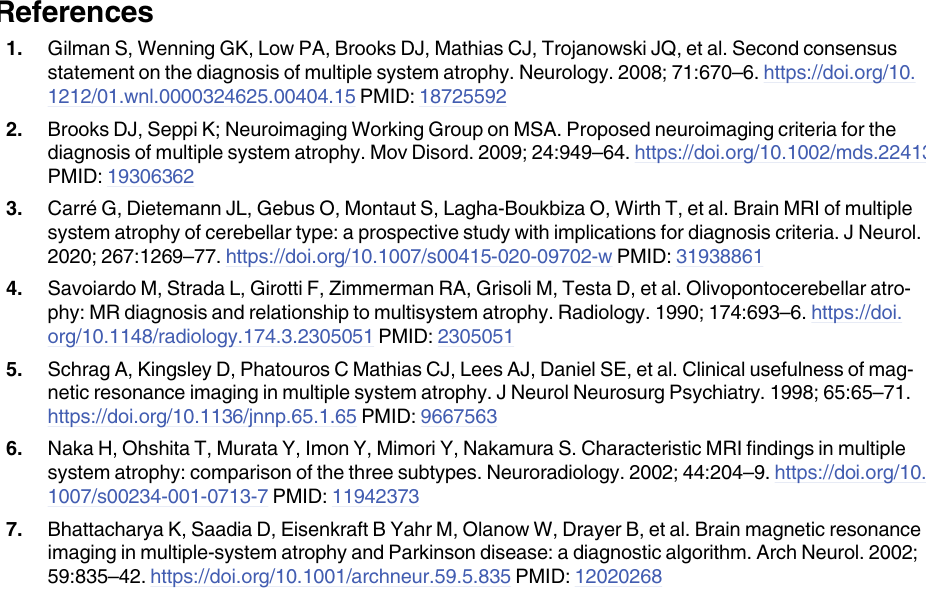
S1 Table. Details of the clinical characteristics of